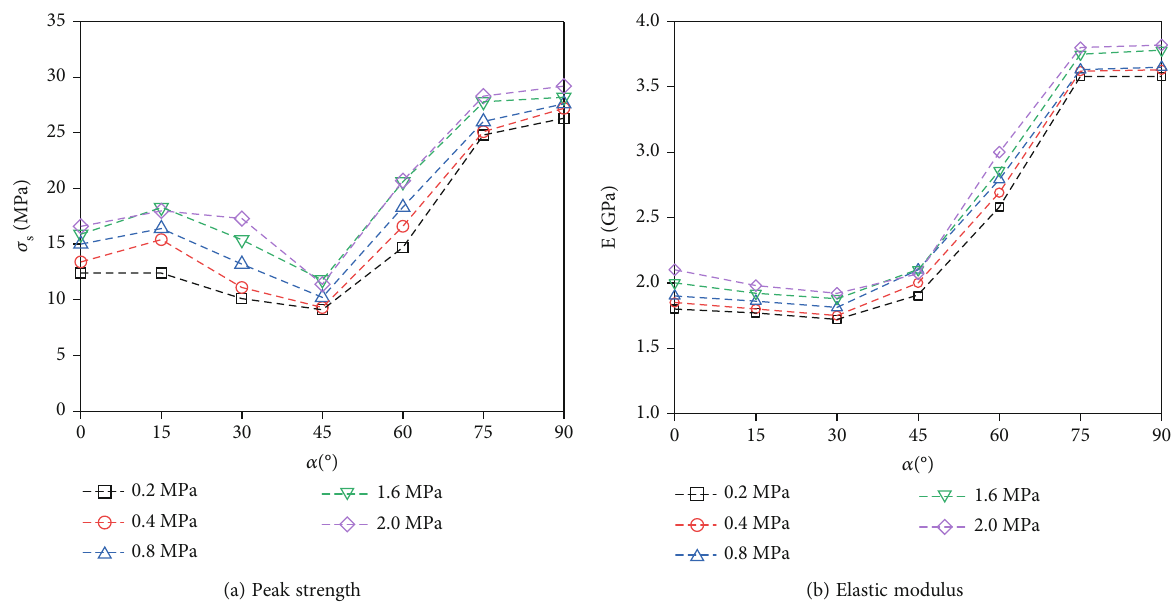
Figure 6: E ff ects of di ff erent dip angles and con fi ning pressures on mechanical parameters of composite rock strata specimens with holes; σ and E stand for peak strength and elastic